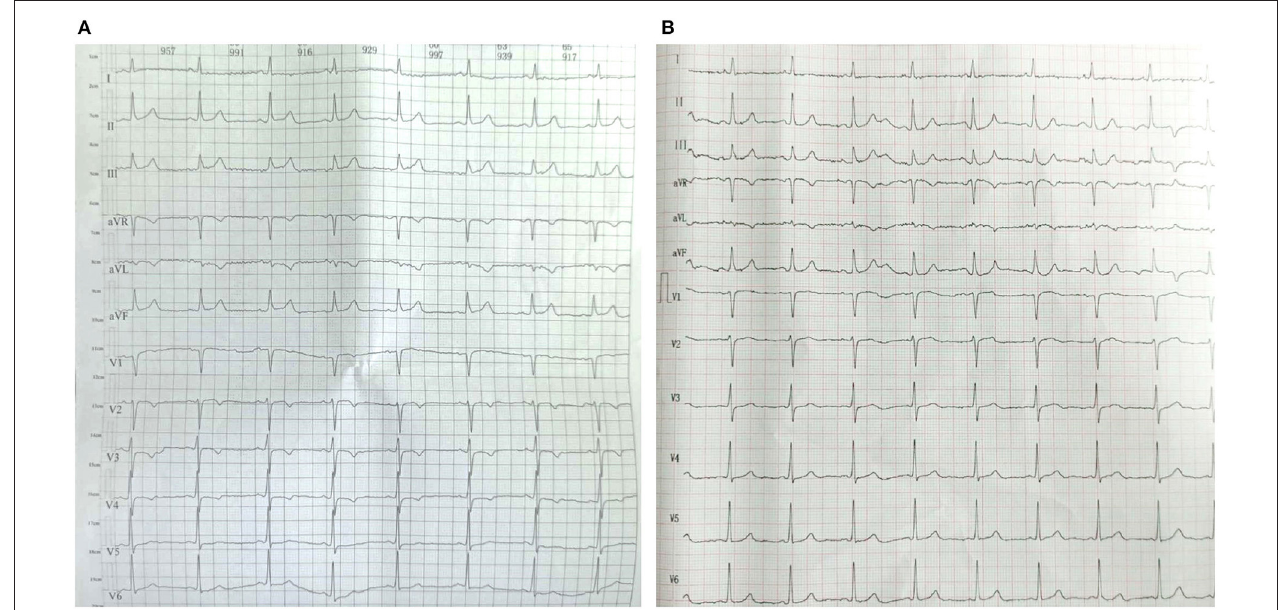
FIGURE 1 | Electrocardiogram of the patient before admission (A) and at discharge (B)